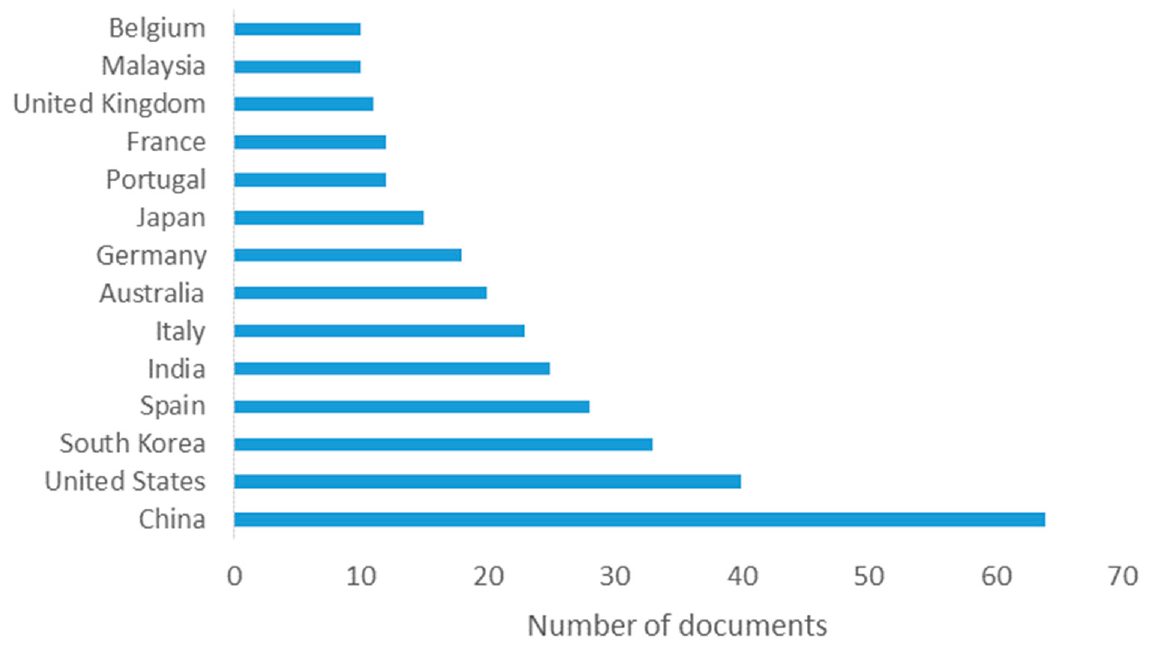
Figure 6. Distribution by region/country among the published articles (min. 10 publications).